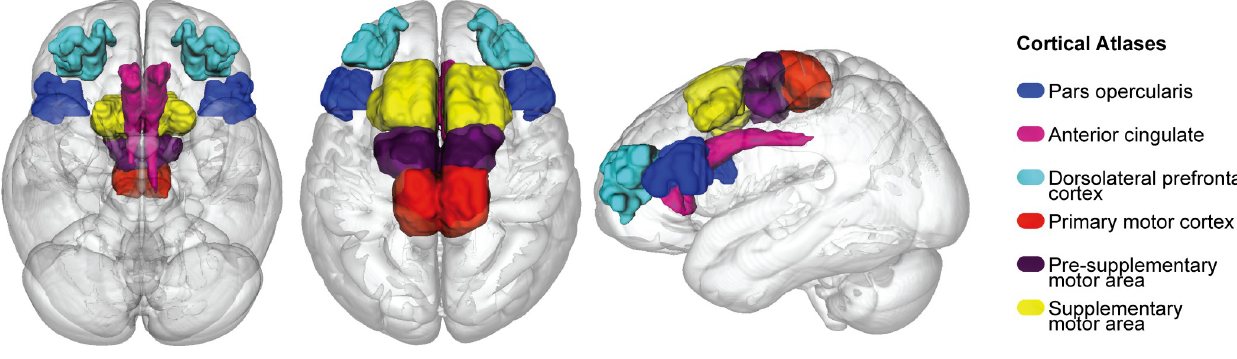
Fig 1. Cortical atlases.